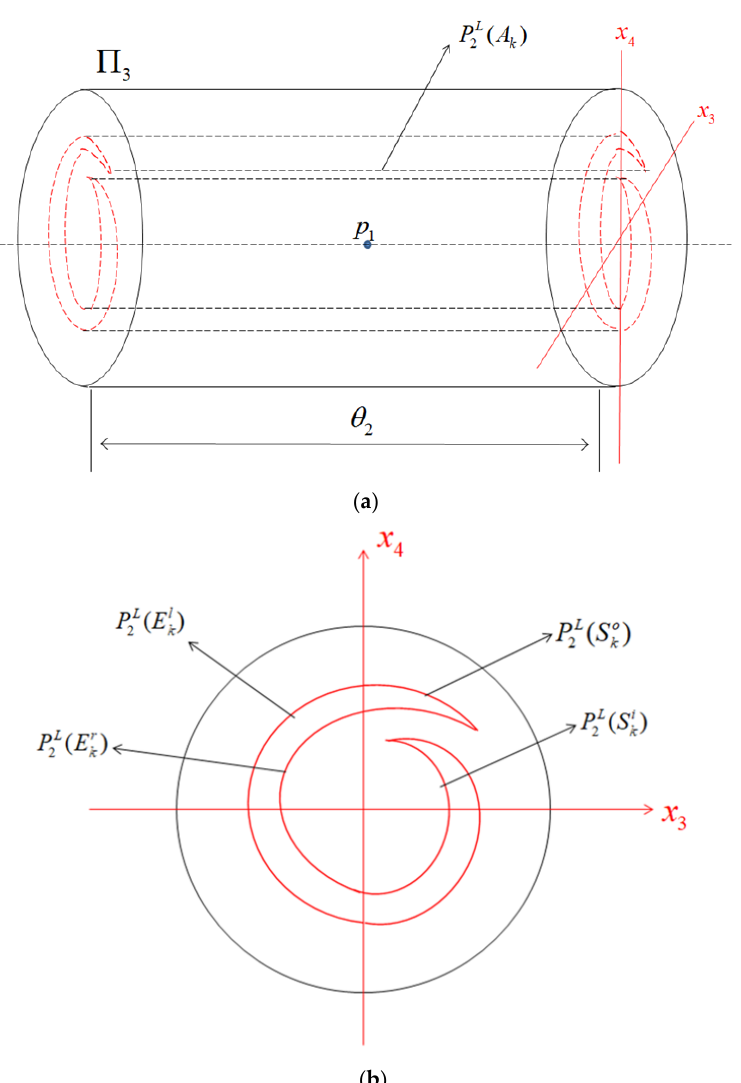
Figure 10. The geometric structure of the Poincare map. ( a ) The Poincare map of three-dimensional structure. ( b ) The cross-section of the logarithmic spiral map. The change process of the cross-section is regarded as the behavior of introducing a vertical line and horizontal sum line on the two-dimensional plane. The four lines can be mapped into a logarithmic spiral structure through the transformation of the Poincare map, as shown in Figure 11.